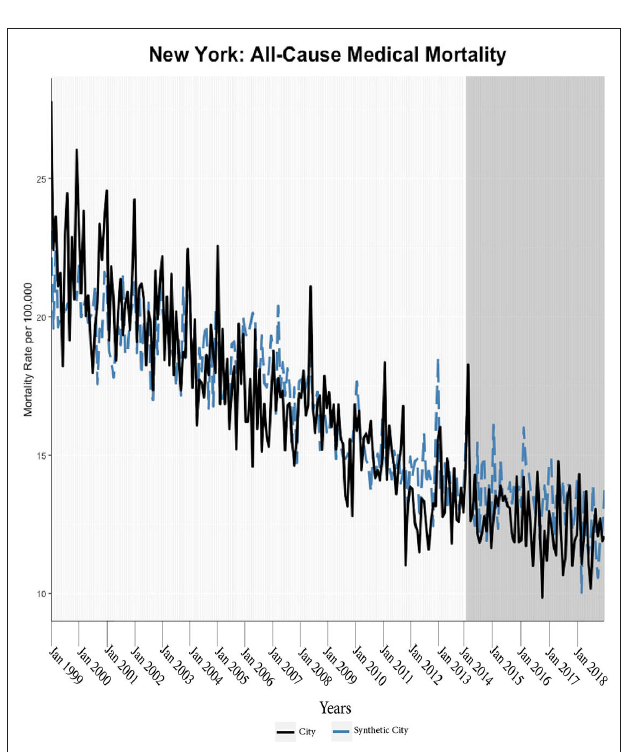
FIGURE 6 | Neoplasm mortality trends: Washington D.C. and synthetic control